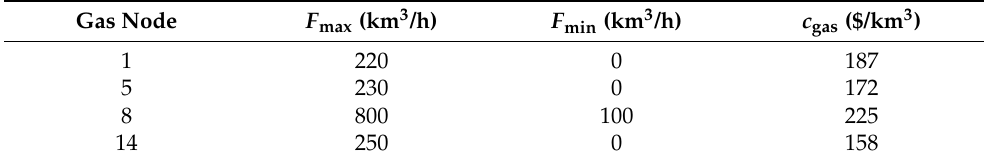
Table A2. Parameters of natural gas well.